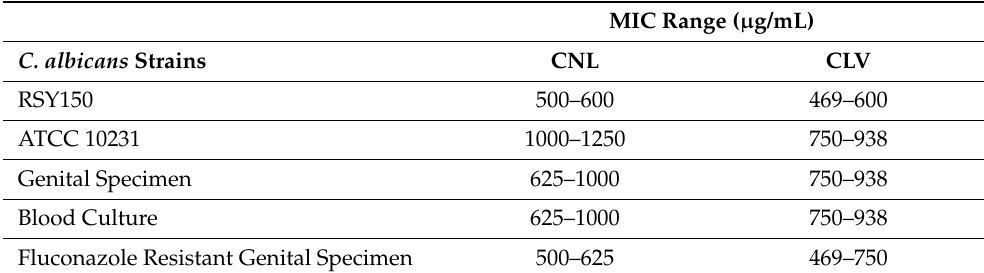
Table 2. Relative sensitivity of C. albicans ATCC 10231, RSY150 and clinical